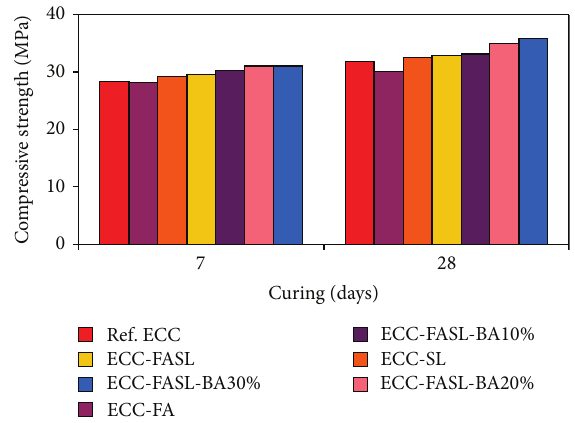
Figure 7: Compressive strength of all ECC mixtures and compari-